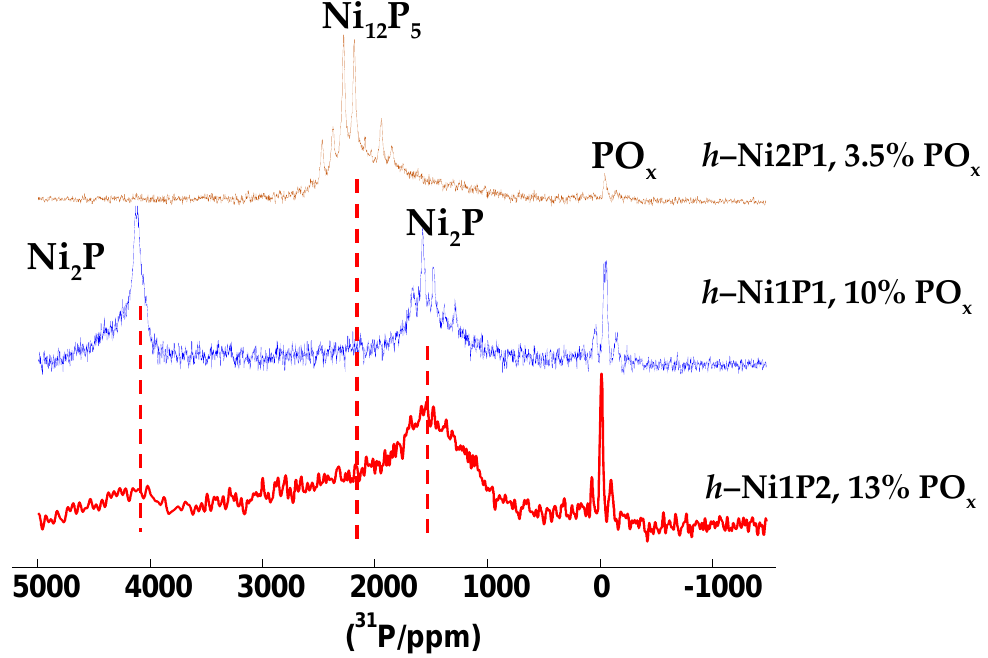
Figure 3. Spin-echo 31 P 14 kHz MAS NMR spectra of high-loaded Ni x P y /SiO 2 catalysts with different Figure 3 . Spin ‐ echo 31 P 14 kHz MAS NMR spectra of high ‐ loaded Ni x P y /SiO 2 catalysts with different initial Ni/P molar ratio (2/1, 1/1 and 1/2 top-down) reduced at 600 ◦ C. Spectra are normalized to the initial Ni/P molar ratio (2/1, 1/1 and 1/2 top ‐ down) reduced at 600 °C. Spectra are normalized to the same amplitude of the highest same amplitude of the highest point.